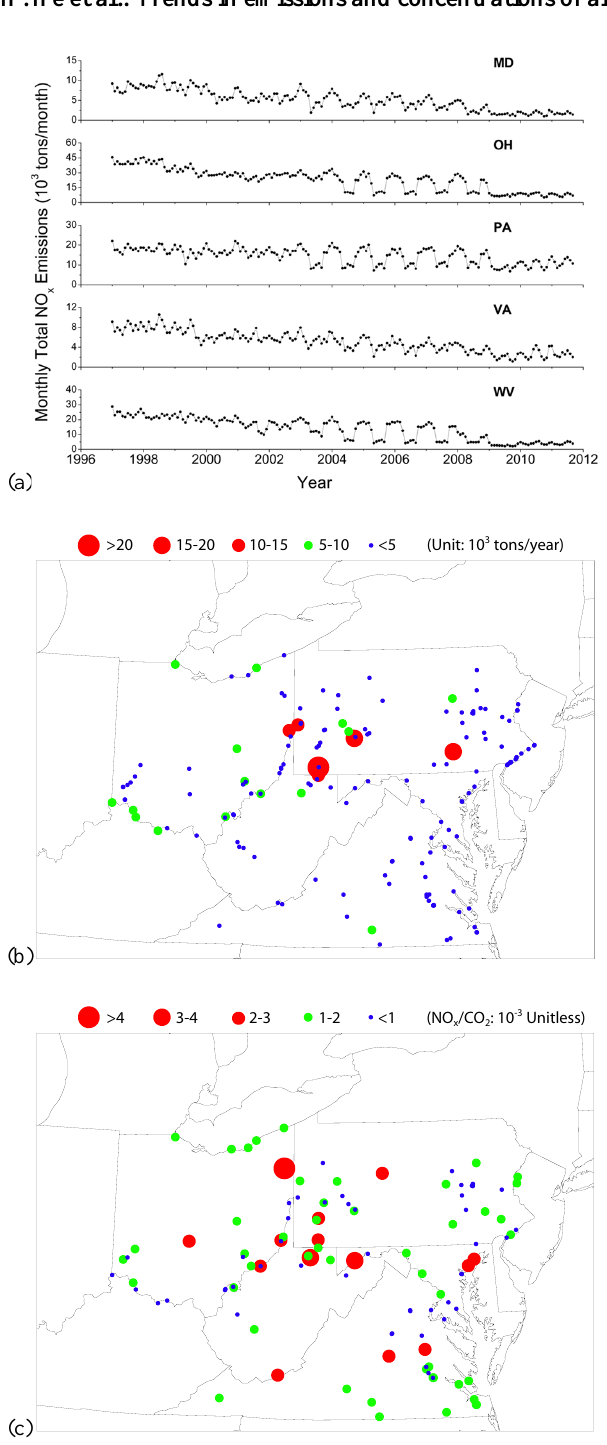
Fig. 2. CEMS emissions of NO x in the research domain: (a) long- term trends of monthly NO x emissions (unit: 10 3 tons) from various states; (b) locations of major NO x point sources, with color and size of circle reflecting the magnitude of emission (as indicated); (c) map of NO x /CO 2 ratios (unit: molmol − 1 ). (b) and (c) are based on the annual emissions data in